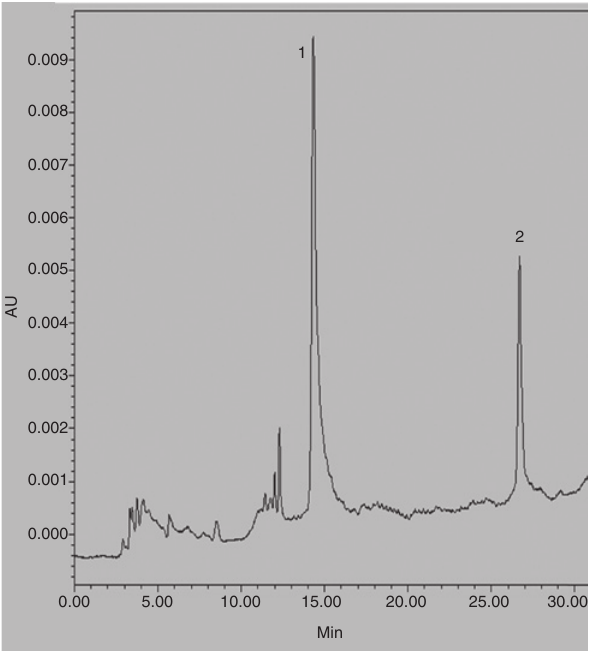
Figure 8: HPLC-UV-vis chromatogram of DSP extracts at 280 nm. Peaks: (1) chlorogenic acid and (2) rutin.